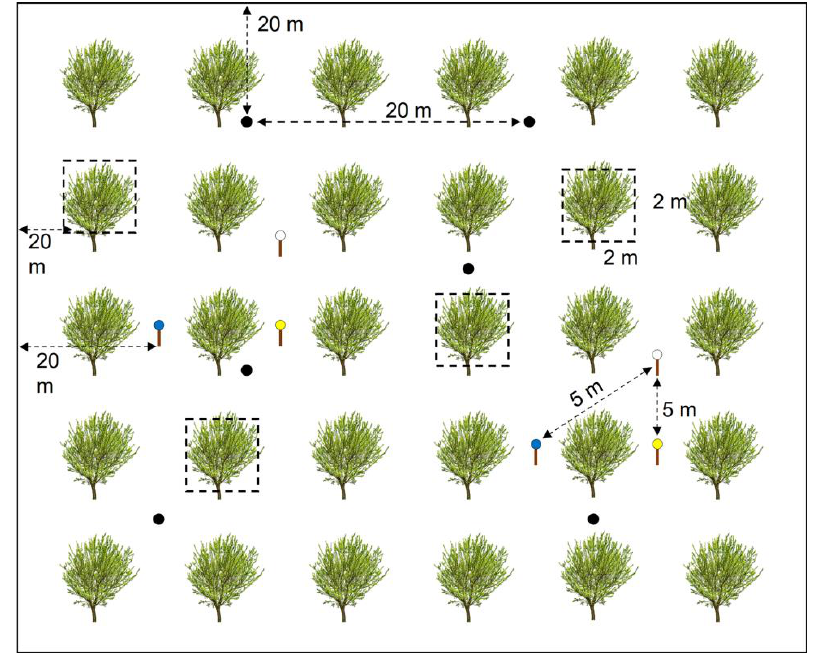
Figure 2. Sampling design. Black circles: pitfall traps; empty squares: 2 m × 2 m vacuuming quadrants; yellow, white, and blue circles: pan traps. Dashed arrows represent the minimum distance between traps or to the grove’s edge.